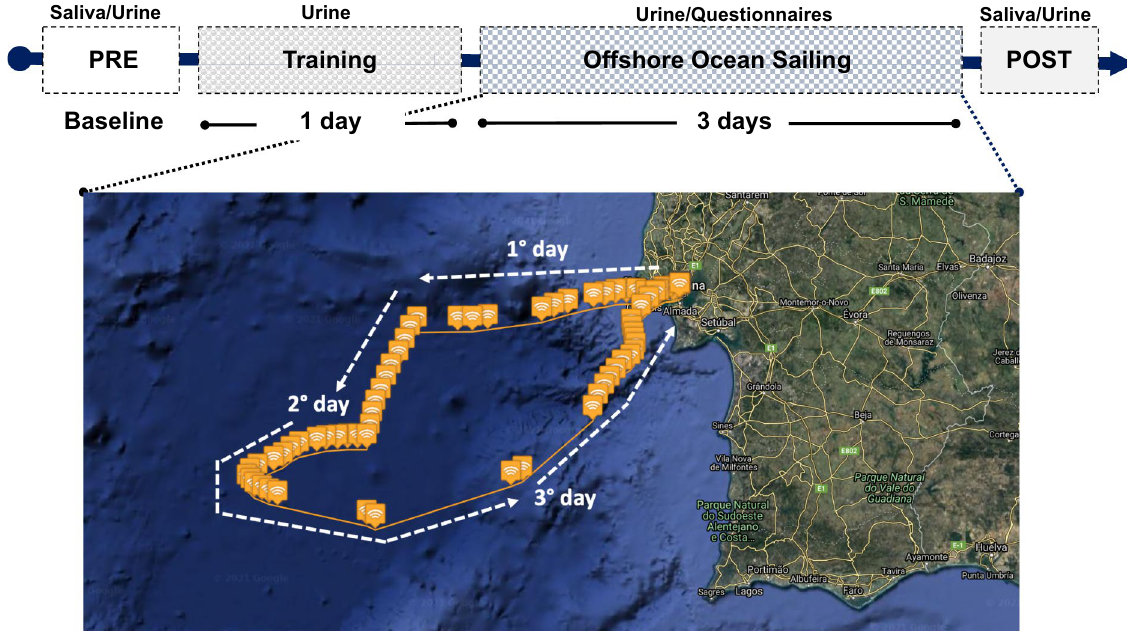
Figure 1. Sketch of the experimental protocol and map showing the navigation route. Data were collected before departure (PRE), during the inshore navigation (Training) during each day of Offshore Ocean Sailing (from 1° to 3° day), and at arrival (POST). GPS data and map were obtained with Spot Gen3, SPOT LCC, Globastar, Inc, Covington, Louisiana, USA. Maps by Google, Inst. Geogr. Nacional. Modified geographic map was edited with Microsoft Office PowerPoint 2007, Microsoft Corporation, Washington, USA, version 16.16.27, https:// www. micro soft. com/ it- it/ micro soft- 365/ power point and at the top was insert the experimental protocol timeline. Weight (kg) Weight (kg) Age Height (cm) PRE